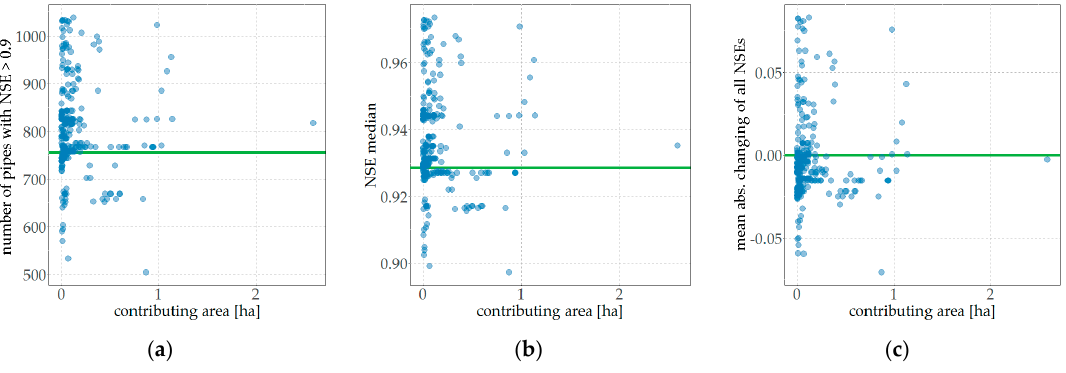
Figure 7. Investigation of linkage between contributing area and calibration performance (horizontal line: uncalibrated model performance): ( a ) number of links with a resulting NSE > 0.9; ( b ) median of all occurring NSE values; ( c ) averaged absolute change in all evaluated NSE compared to the uncalibrated model.